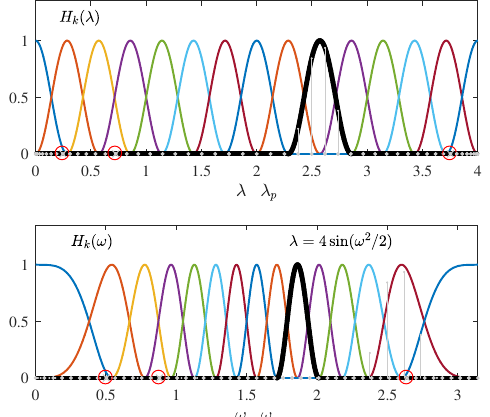
Figure 8. Transfer functions in the spectral eigenvalue and frequency domains for classical analysis: (top) The eigenvalue spectral domain transfer functions H k ( λ p ) , p = 1,2, . . . , N , k = 0,1, . . . , K − 1, for K = 15 and 0 ≤ λ ≤ λ max = 4. (down) The frequency spectral domain transfer functions H k ( ω p ) , p = 1,2, . . . , N , k = 0,1, . . . , K − 1, for K = 15 and 0 ≤ ω ≤ π . Horizontal axis represents the continuous variable λ and discrete values λ p , p = 1,2, . . . , N , corresponding to the eigenvalues and denoted by gray dots along the axis. The same notation is used for frequency ω and its discrete values ω p that correspond to λ p